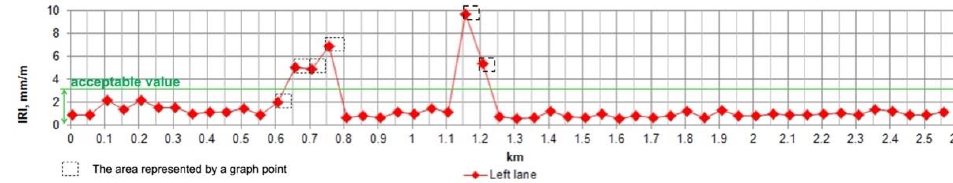
Figure 10. The longitudinal evenness graph of the tested road section obtained with a laser profilo- graph.